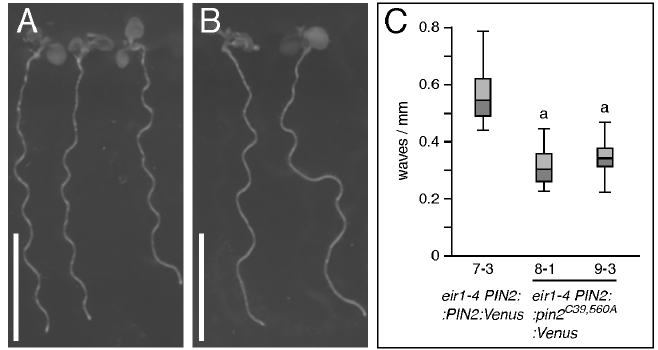
Figure 6. Analysis of PIN2::pin2 C39,560A :Venus lines. ( A , B ) Comparison of: eir1-4 PIN2::PIN2:Venus ( A ) and eir1-4 PIN2::pin2 C39,560A :Venus ( B ) seedlings at 6 DAG grown on vertically oriented nutrient plates. Size bars correspond to 10 mm; ( C ) Root waviness of eir1-4 PIN2::PIN2:Venus and two independent eir1-4 PIN2::pin2 C39,560A Venus lines at 6 DAG, grown on vertically orientated agar (1.5% ( w / v )) nutrient plates. In total, 25–28 seedlings were tested for each genotype. “a” indicates a significant difference to eir1-4 PIN2::PIN2:Venus ( p < 0.01), determined by One-way ANOVA with post-hoc Tukey HSD test. Whiskers represent the entire range of outliers obtained in the datasets; dark grey and light grey boxes display first and third quartiles,